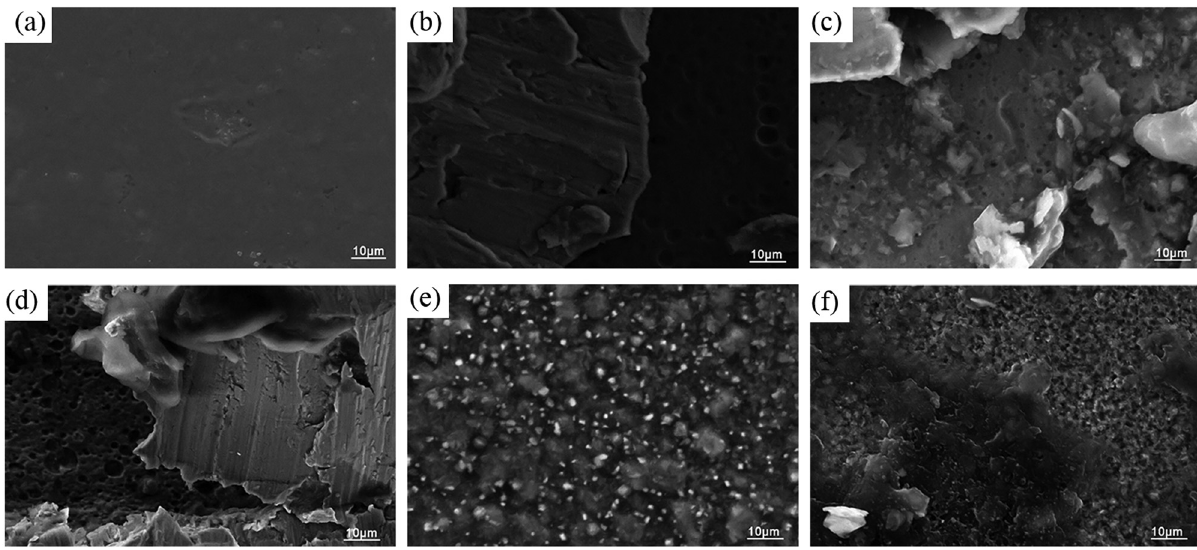
Figure 7: Surface SEM image of alloy resin composite after the bonding test. ( a ) Unanodized; ( b ) two - step anodizing; ( c ) T - 30 min; ( d ) 10 s; ( e ) 30 s; ( f ) 60